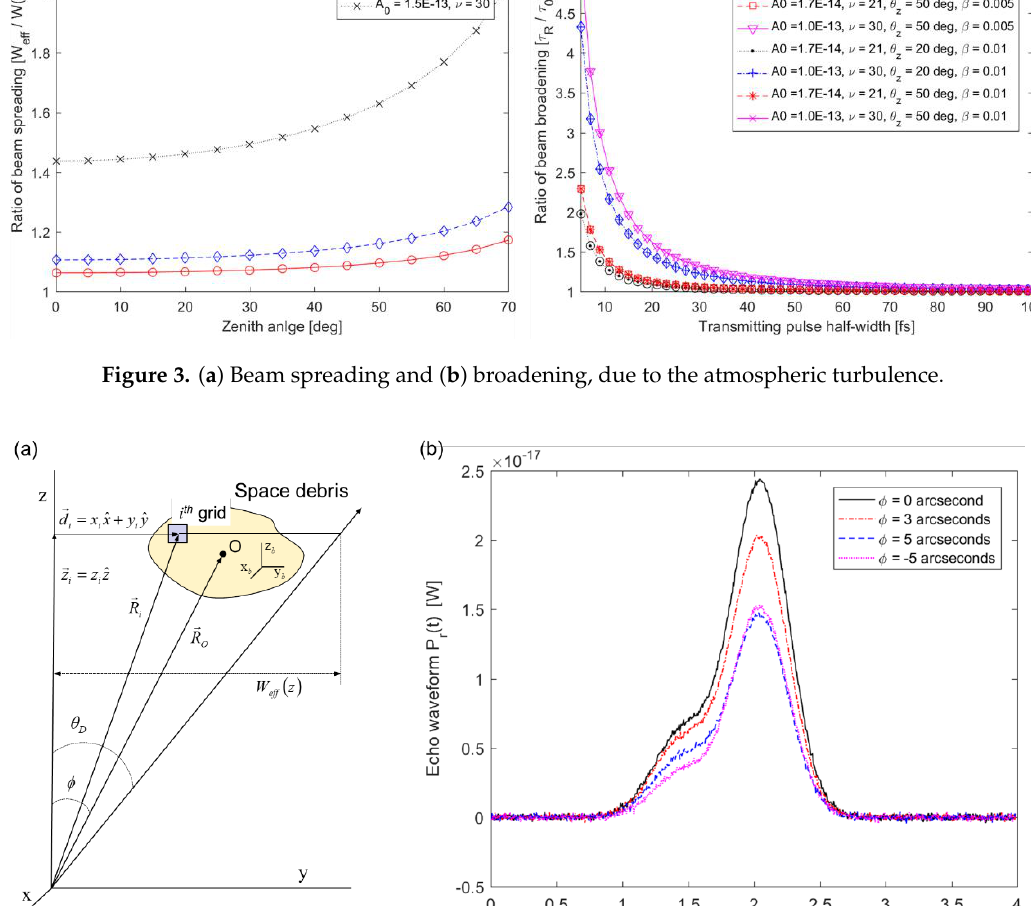
Figure 4. Illustration of ( a ) laser tracking with a pointing error, and ( b ) the echo laser pulse waveforms (ELPWs) for four pointing errors. The ELPWs were obtained by employing the reflected surface or orientation identical to Figure 5.